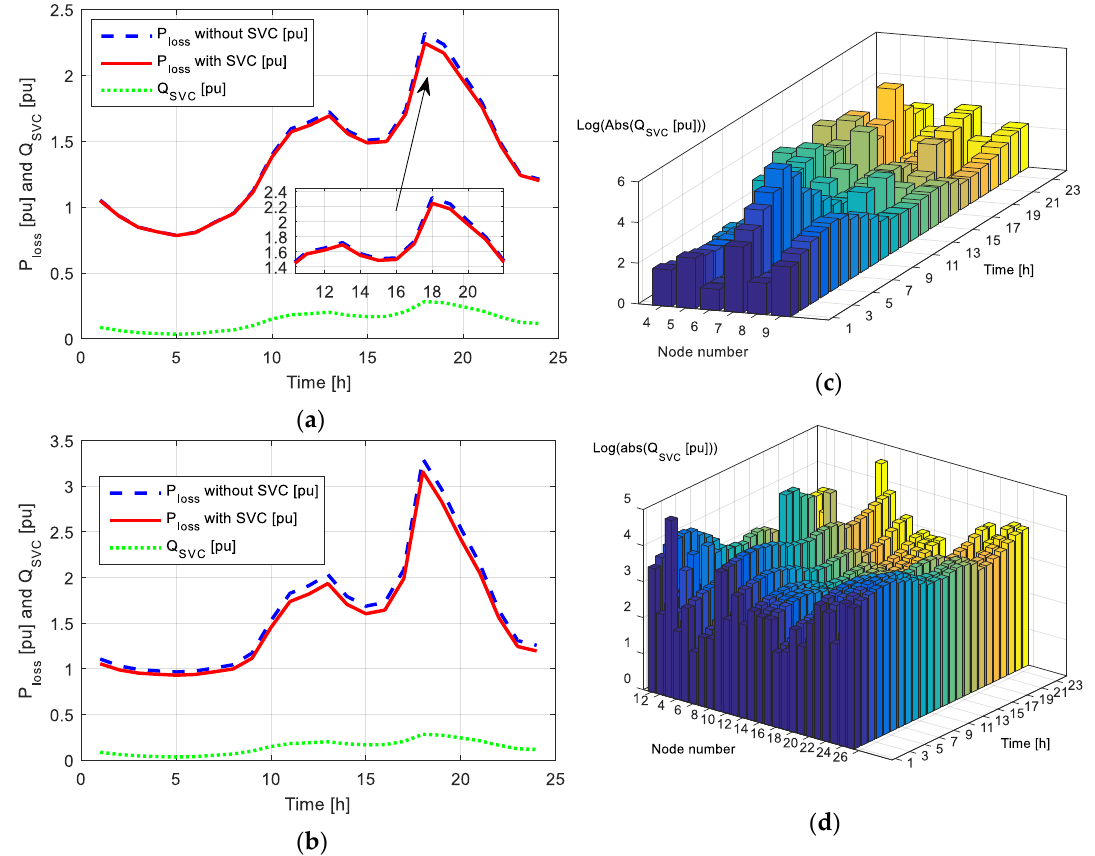
Figure 9. Power losses and reactive power of an SVC device connected in the optimal node for ( a ) IEEE 9 and ( b ) IEEE 30 test bus system, as well as 3D graphs (node number-time-reactive power) for ( c ) IEEE 9 and ( d ) IEEE 30 test bus systems.